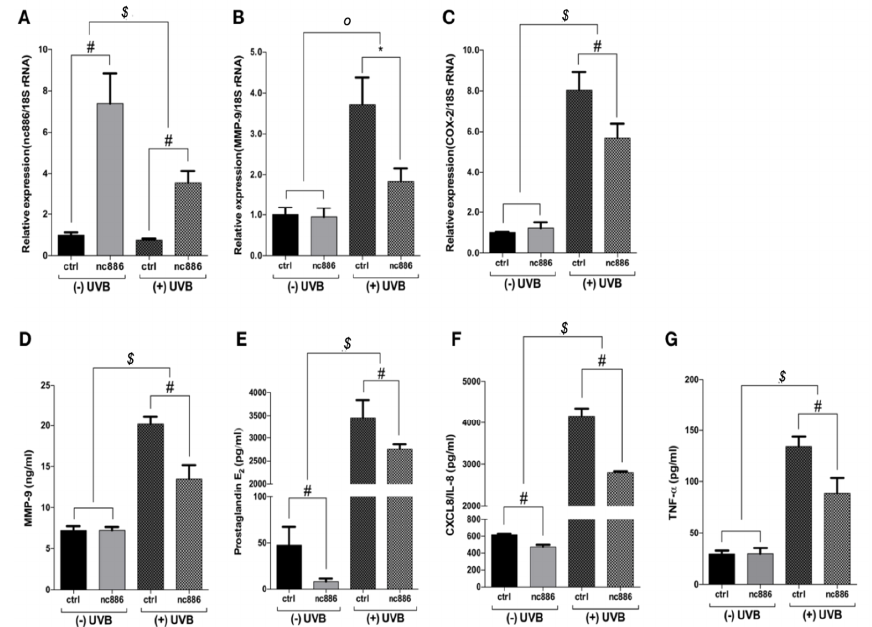
Figure 1. Effect of overexpression nc886 on the production of inflammation-related proteins increased by UVB. Cells were transfected with 1 µg of nc886 gene. Then, 48 h after transfection, the cells were irradiated with UVB (5 mJ/cm 2 ). RNA samples were analyzed with quantitative real-time polymerase chain reaction (qRT-PCR) and the cell culture fluid with ELISA. Values measured for ( A ) nc886, ( B ) MMP-9, ( C ) COX-2 were indicated in a fold change compared to the control. The mRNA level was normalized with the expression of 18S rRNA. The measured values for ( D ) MMP-9, ( E ) PGE 2 , ( F ) IL-8, and ( G ) TNF- α were indicated in absolute concentration for each. * p < 0.05, # p < 0.01, compared to basal levels; o p < 0.05, $ p < 0.01, compared between ( − ) UVB and ( + ) UVB